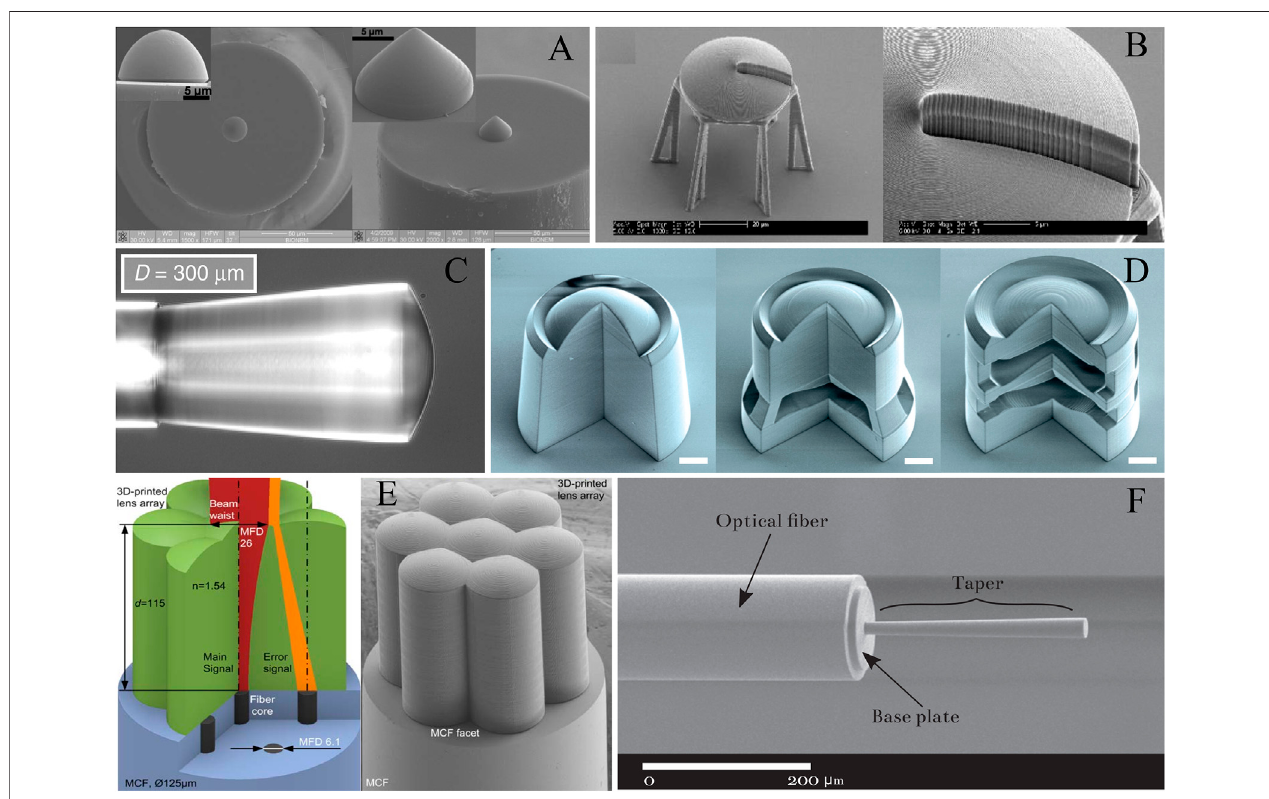
FIGURE 1 | Optical fi ber integrated polymer microlenses printed by TPP. (A) Convergent lens and axicon lens fabricated on end face of SMF (Cojoc et al., 2010; Liberale et al., 2010). (B) Spherical lens with an azimuthal spiral phase plate on top for generating OAM beams in free space (Weiss and Marom, 2016). (C) Collimation lens printed on the top of SMF (Gissibl et al., 2016b). (D) Ultra-compact compound lens systems with numerous refractive surfaces for endoscopy applications (Gissibl etal.,2016c). (E) Microlensarrayprintedonthetopofsingle-modeandmulti-core fi berforfree-spacelightcoupling(Dietrichetal.,2017). (F) Beamexpansiontaper for SMF-SMF coupling (Vanmol et al.,